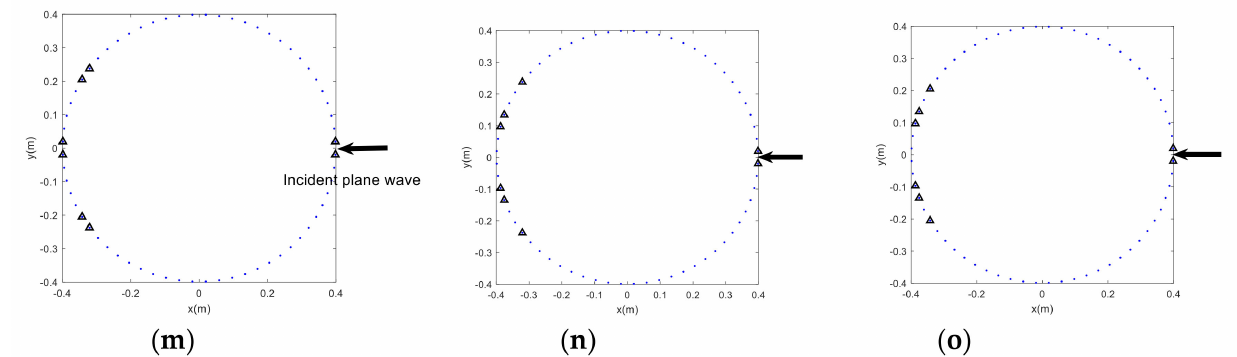
Figure 2. Scattered sound field and the results of loudspeaker placement for each method from 400 Hz to 1000 Hz: ( a ) scattered sound field of the 400 Hz primary source; ( b ) scattered sound field of the 700 Hz primary source; ( c ) scat- tered sound field of the 1000 Hz primary source; ( d ) Uni-RLS (400 Hz); ( e ) Uni-RLS (700 Hz); ( f ) Uni-RLS (1000 Hz); ( g ) CLASSO-RLS (400 Hz); ( h ) CLASSO-RLS (700 Hz); ( i ) CLASSO-RLS (1000 Hz); ( j ) LASSO-RLS- γ C (400 Hz); ( k ) LASSO-RLS- γ C (700 Hz); ( l ) LASSO-RLS- γ C (1000 Hz); ( m ) LASSO-RLS- γ NL (400 Hz); ( n ) LASSO-RLS- γ NL (700 Hz); and ( o ) LASSO-RLS- γ NL (1000 Hz).